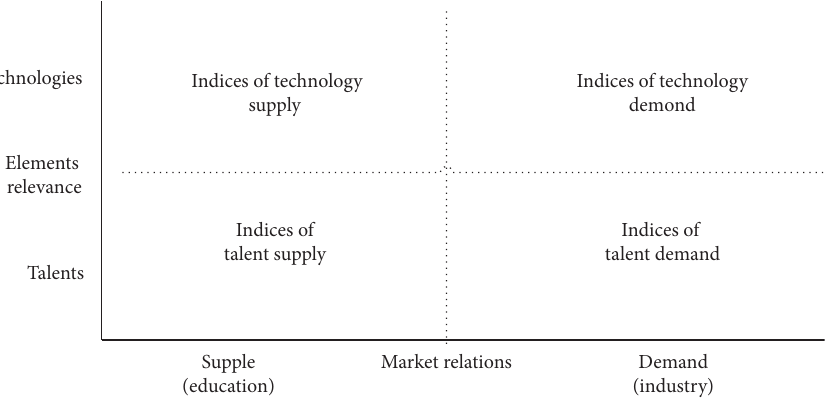
Figure 2: Two-dimensional four-quadrant EIS for the PEI performance in the high-tech industry. Table 1: EIS for PEI performance in the high-tech